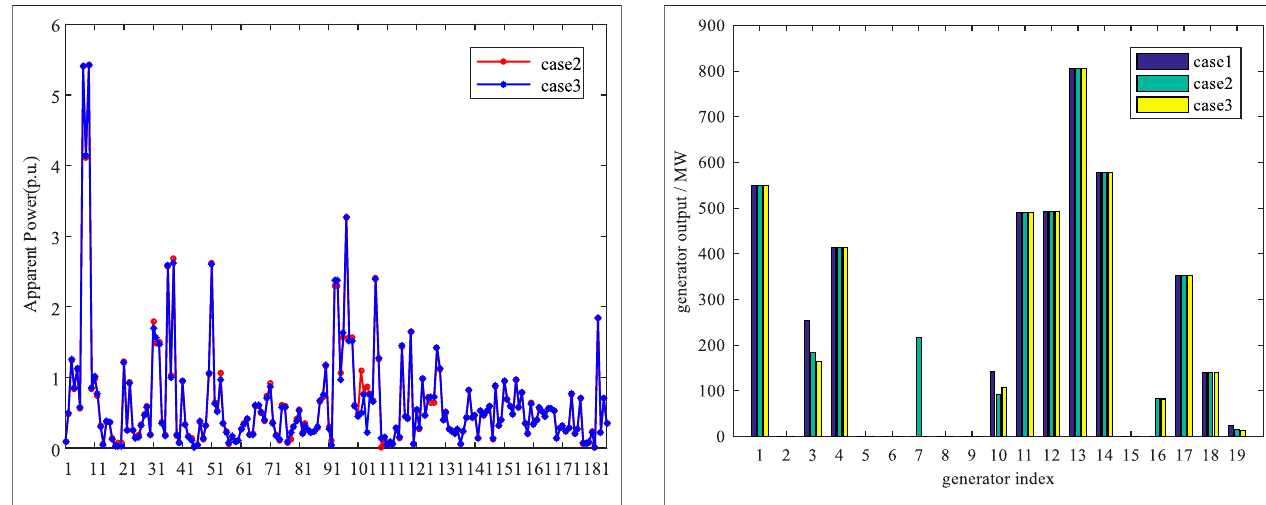
FIGURE 4 | Comparison of apparent power.